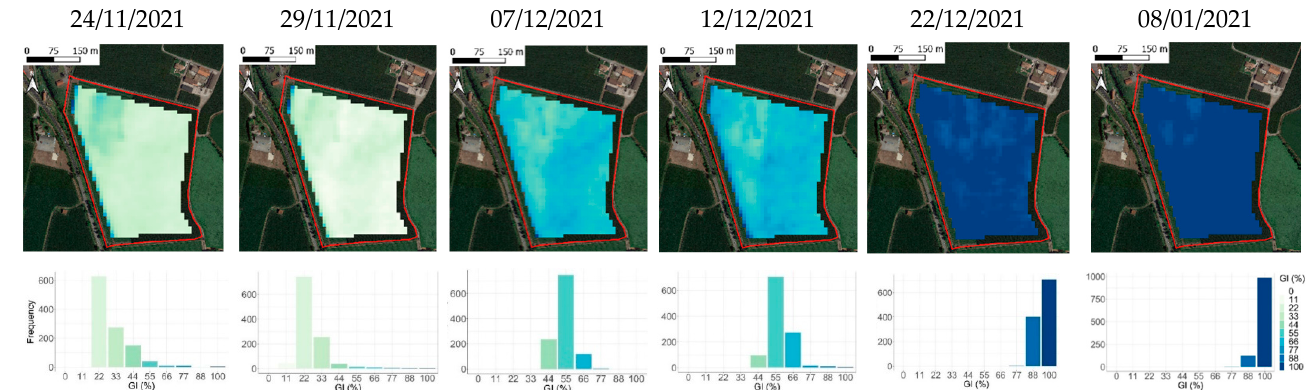
12 of 16 Figure 7. Maps of the results of the multi-temporal cluster analysis of two vegetation indices de- scribing cover crop frost damage (MMSR and CCCI, Modification to Modified Simple Ratio and Canopy Chlorophyll Content Index) for the field in Ghedi. Clusters are mapped in increasing order corresponding to the value of the vegetation index of the center of the cluster. Clusters codified with lower values are those with higher frost damage. Clusters with the same code in different dates are characterized by similar values of the vegetation index. The multi-temporal clustering classified differences of VI mainly among dates and not within the field, indicating that sharp differences of the VI are due to frost damage and not to spatial variability detected by the satellite. The index MMSR clearly showed a discontinuity between 12 and 22 December (Figure 7), when the GI estimated from ground measurements was higher than 60%: on that date, the map of MMSR suggests that the field was mostly damaged (cluster 2). The CCCI was able to identify some spatial differ- ences within the field. Nonetheless, after 22 December it showed a decrease in its values corresponding to 100% of measured GI (Figure 7). Due to its high sensitivity to frost damage, MMSR was used to study the spatio-tem- poral distribution of the assessed frost damage in the fields of Ghedi (Figure 8) and Al- fianello (Figure 9). The field in Ghedi was chosen as it was representative of the sowing date of common practice, while Alfianello represents an earlier sowing date. The maps of the estimated GI were consistent with the spatial pattern observed on the ground during monitoring. At both sites the frequency of high GI increased over time. As a consequence of sub-zero temperatures recorded at the end of November (Table 3), after 29 November